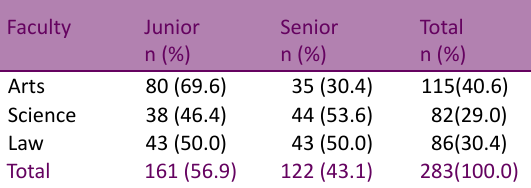
Table 1- Distribution of students by Faculty and seniority